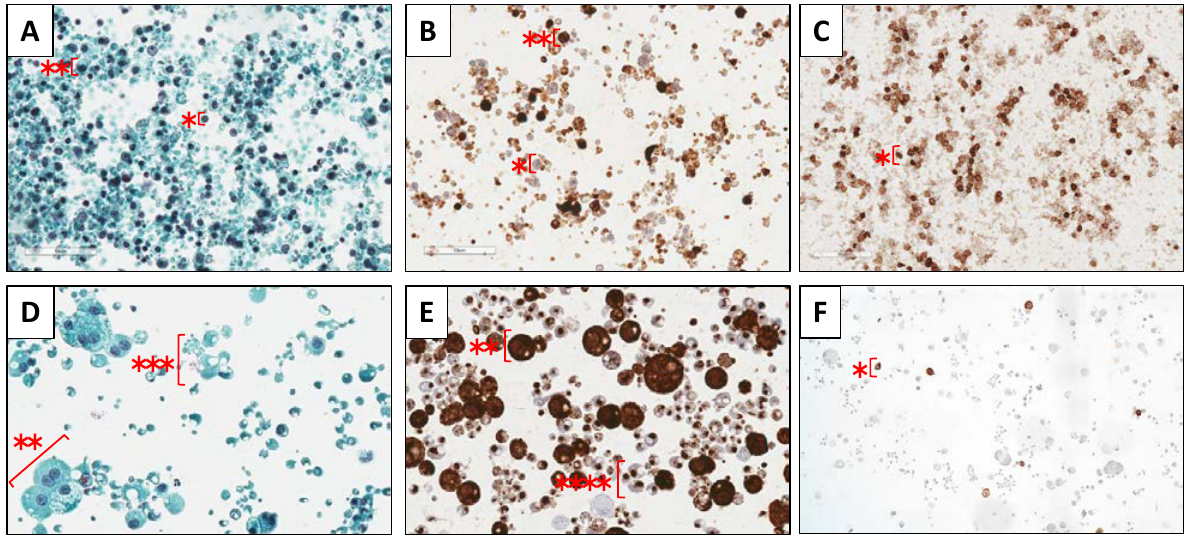
Figure 1. Cytochemical (Papanicolaou stain ( A , D )) and immunocytochemical sections (CK AE/AE3 stain ( B , E ); CD45 stain ( C , F )) of HM cells of colostrum ( A – C ) and mature HM ( D–F ). Note: *, leukocytes; **, glandular epithelial cells; ***, apocrine secretions of lipid globules. Table 1 provides cell counts of glandular epithelial cells, leukocytes, and keratinocytes in the set of HM samples analyzed. The colostrum sample was markedly different from transitional and mature HM samples based on the number of cells and %leukocytes. Table 1. Total cell count and percentage of cell types determined in HM samples. Colostrum Transitional Milk Mature Milk Total cell count (cells/HPF in 500 µL) 706 196 (137) 16 (30) Glandular epithelial cells (%) 82 94 (2) 98 (2) Leukocytes (%) 18 5 (4) 1 (1) Keratinocytes (%) 0 1 (2) 1 (1) Note: Values represent median (IQR, interquartile range).